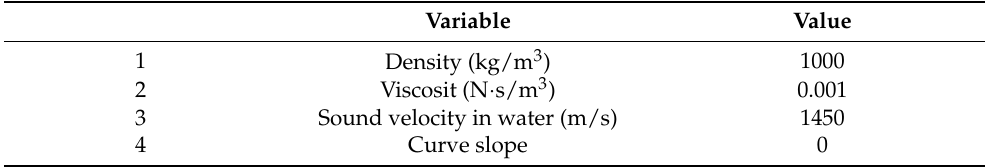
Table 3. Properties of the